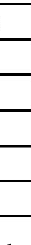
Figure 1. Blockchain ledger data